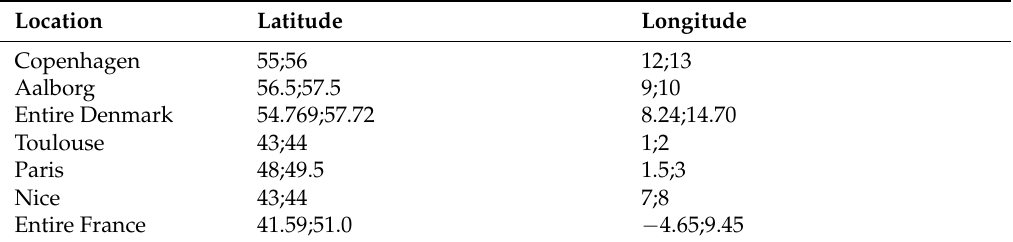
Table A1. Scheme for generating the location of requests. Uniform distributions to and from for both lattitude and longitude. Information gathered from www.latitudelongitude.org.